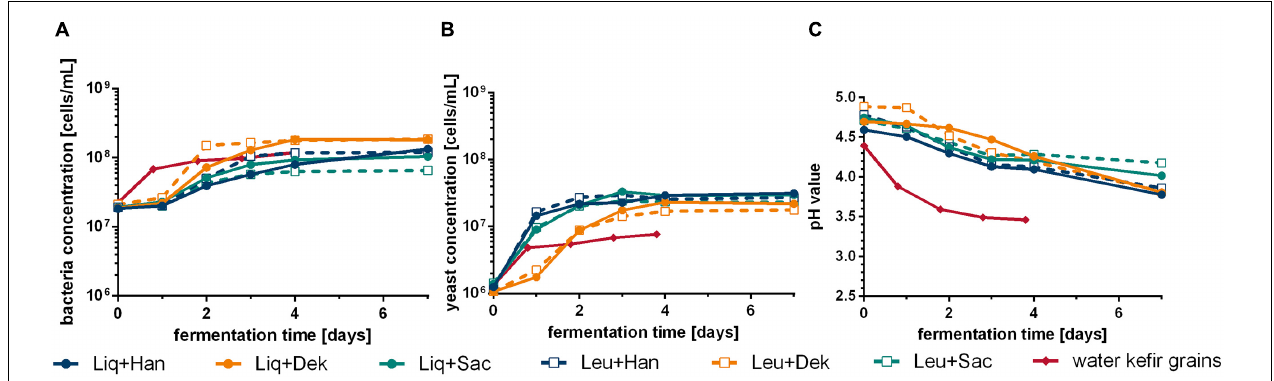
FIGURE 1 | Course of bacteria (A) and yeast (B) cell concentration and pH change (C) during WK fermentation with different starter culture combinations. Data are the mean value of biological duplicates (LAB–yeast combinations) or triplicates (grains). WK, water kefir; LAB, lactic acid bacteria.